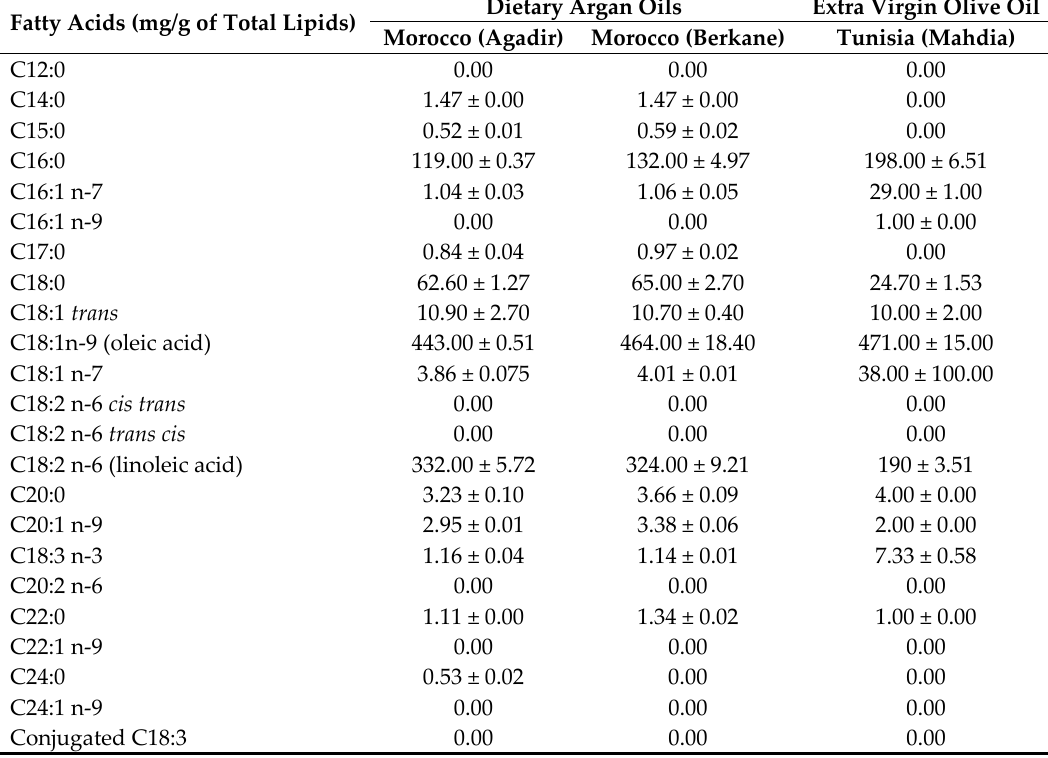
Table 1. Fatty acids content of dietary argan oils (Agadir, Berkane; Morocco) and extra virgin olive oil (Madhia,